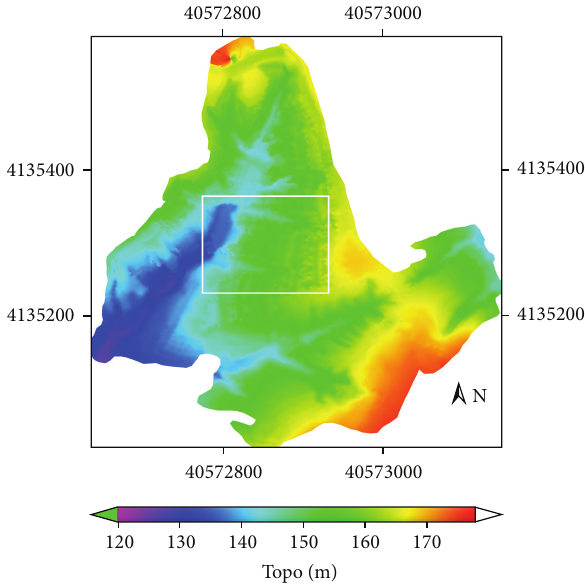
Figure 3: Digital elevation model of the study